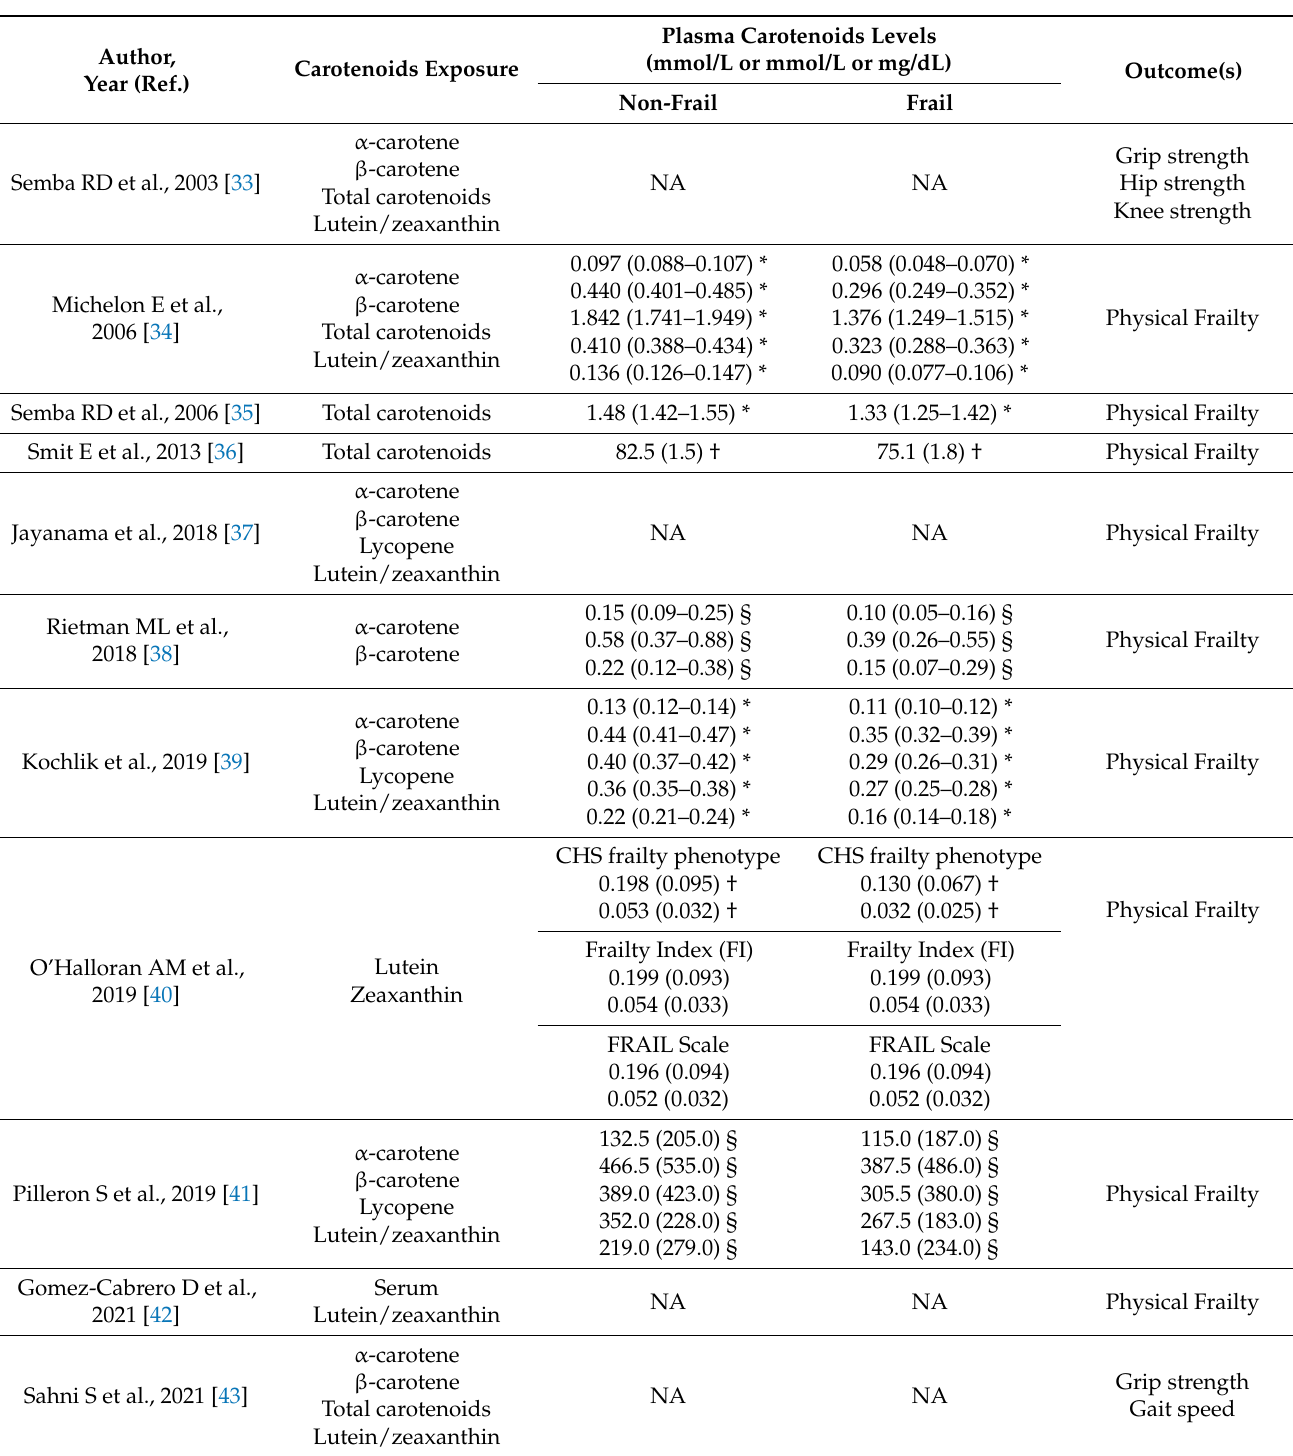
Table 3. Descriptive summary reporting differences in plasma carotenoid values by frailty status (presence/absence) across selected